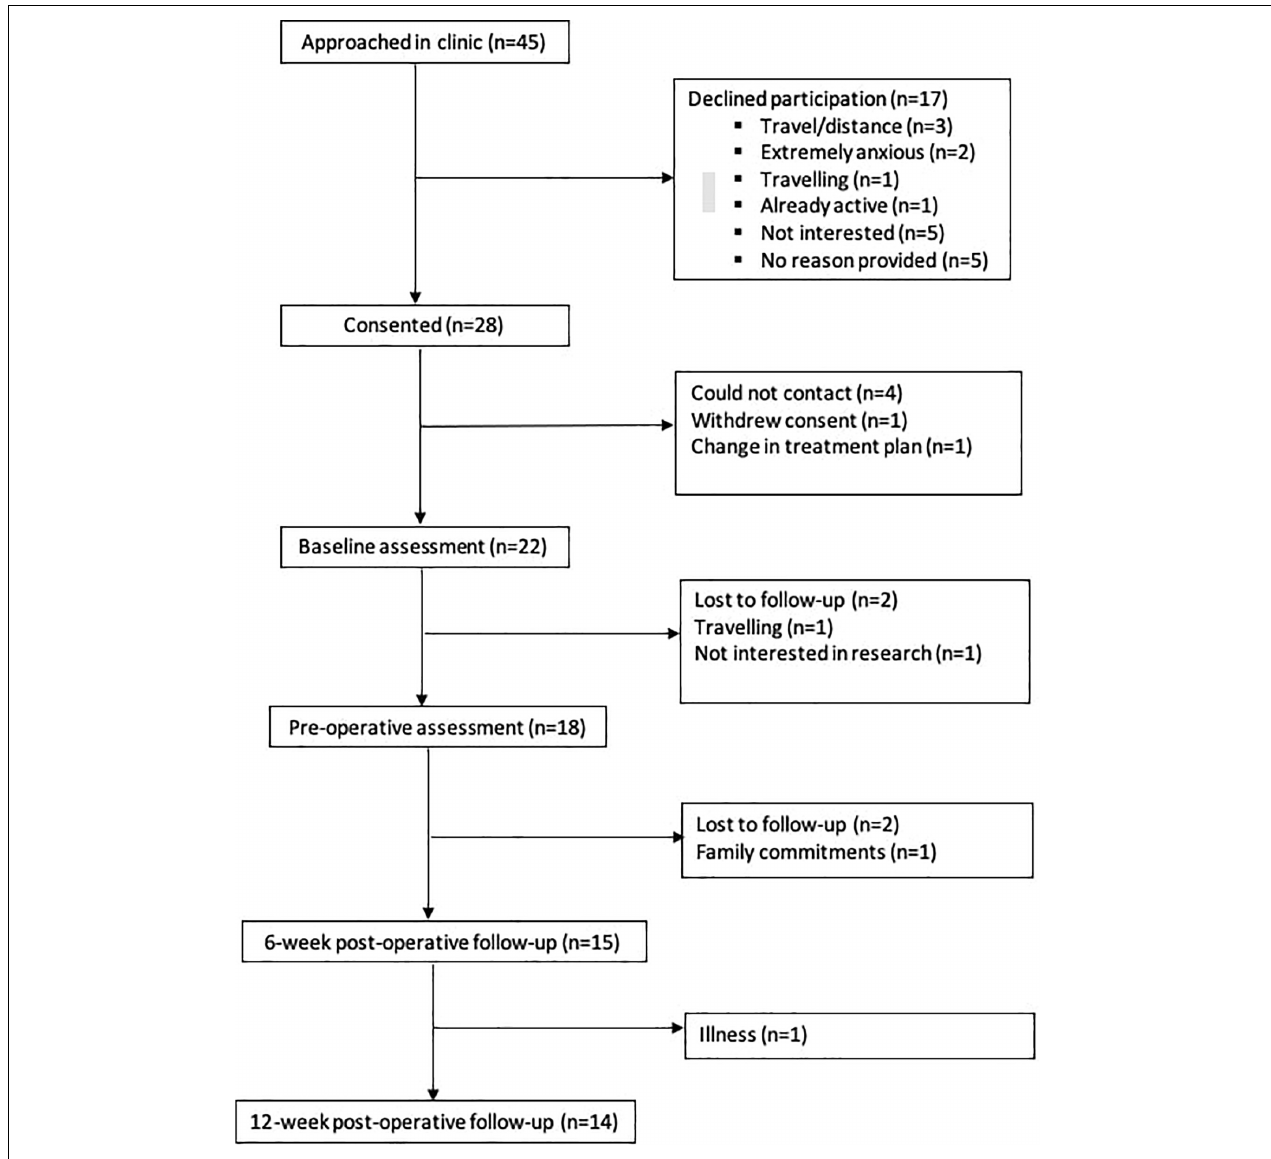
FIGURE 1 | Study flow